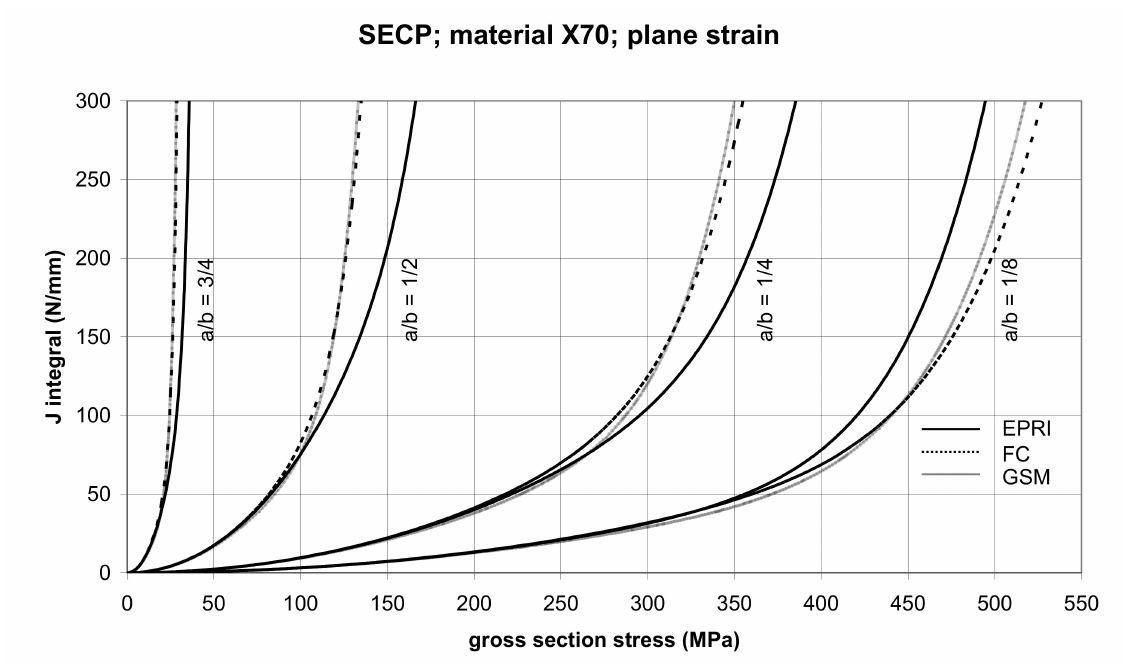
Figure 17. Comparison of J integral for SECP X70 steel specimens in the plane strain condition as determined by the EPRI, GSM, and FC